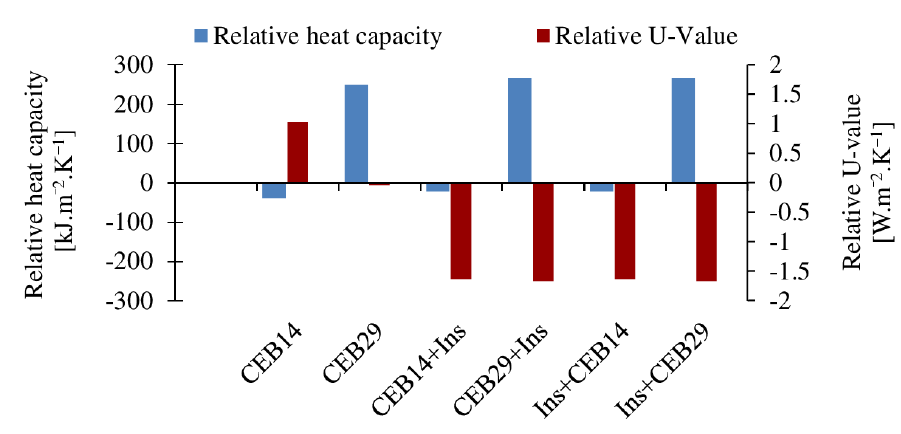
Figure 5. Relative heat capacity and thermal transmittance of the walls.